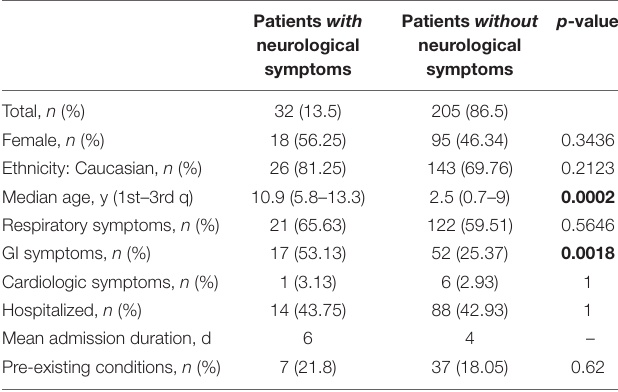
TABLE 1 | Comparison between patients with and without neurological